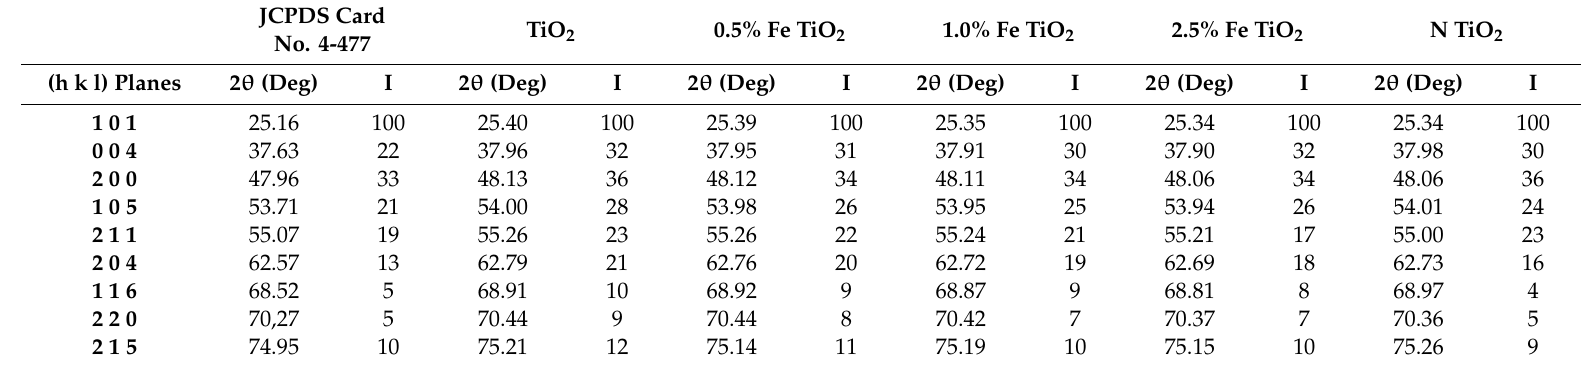
Table 2. XRD data of the photocatalysts based on titanium dioxide.